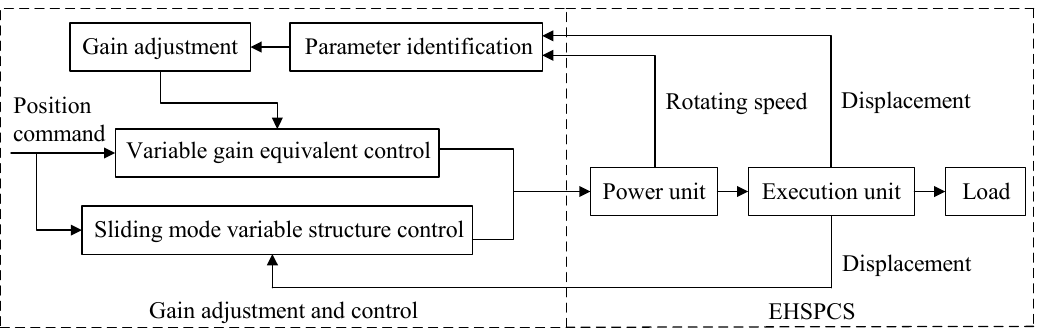
Figure 4. Sliding mode variable structure control architecture of the EHSPCS.